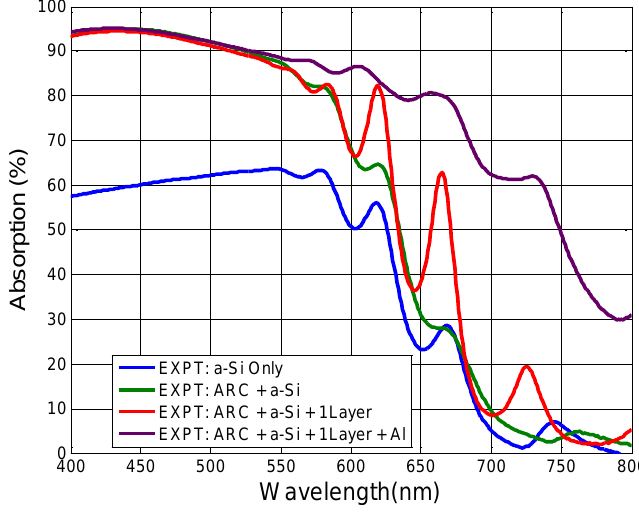
Figure 13. Absorption characteristics for the different fabricated structures. The first structure has no light trapping (blue plot), the second incorporates an AR coating (green plot), the third has the AR coating plus the one layer DBR (red plot), the final plot has the AR coating, 1 Layer DBR and the aluminum layer (purple